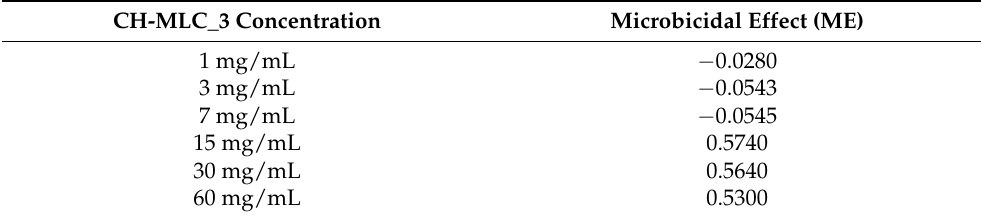
Table 3. Microbicidal effect (ME) of increasing concentration of CH-MLC_3.